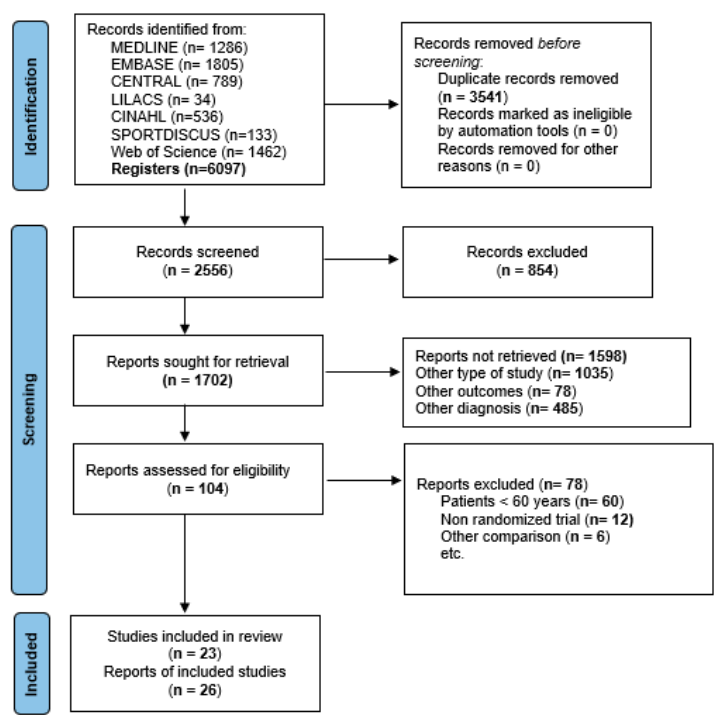
Figure 1. Flow chart diagram.